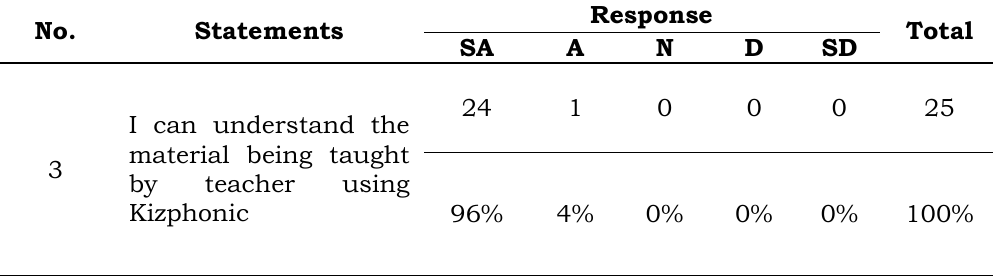
Table 5. Response to the questionnaire number 3